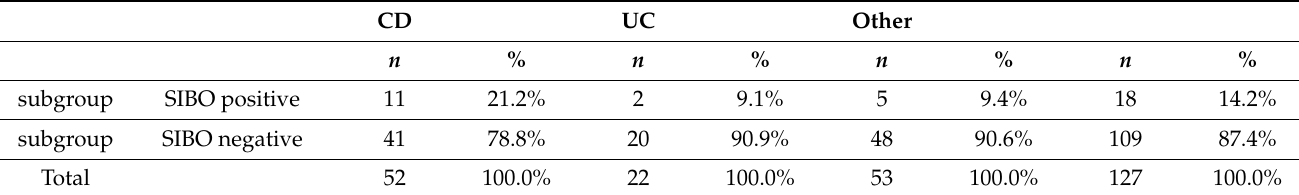
Table 5. Patients with positive SIBO test in accordance with the underlying disease comparing patients with CU, UC, and other diagnosis and age.